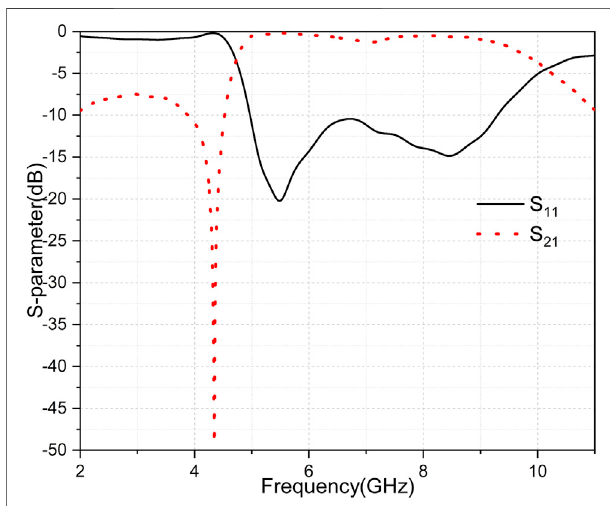
FIGURE 7 | Bandpass fi lter simulation results of SRR-based coplanar waveguide structure.